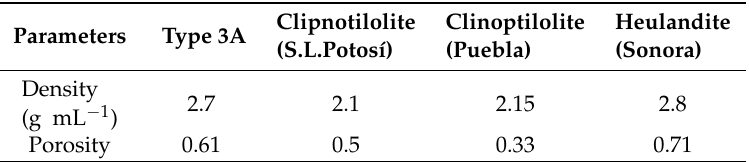
Table A8. Physical and chemical analysis of